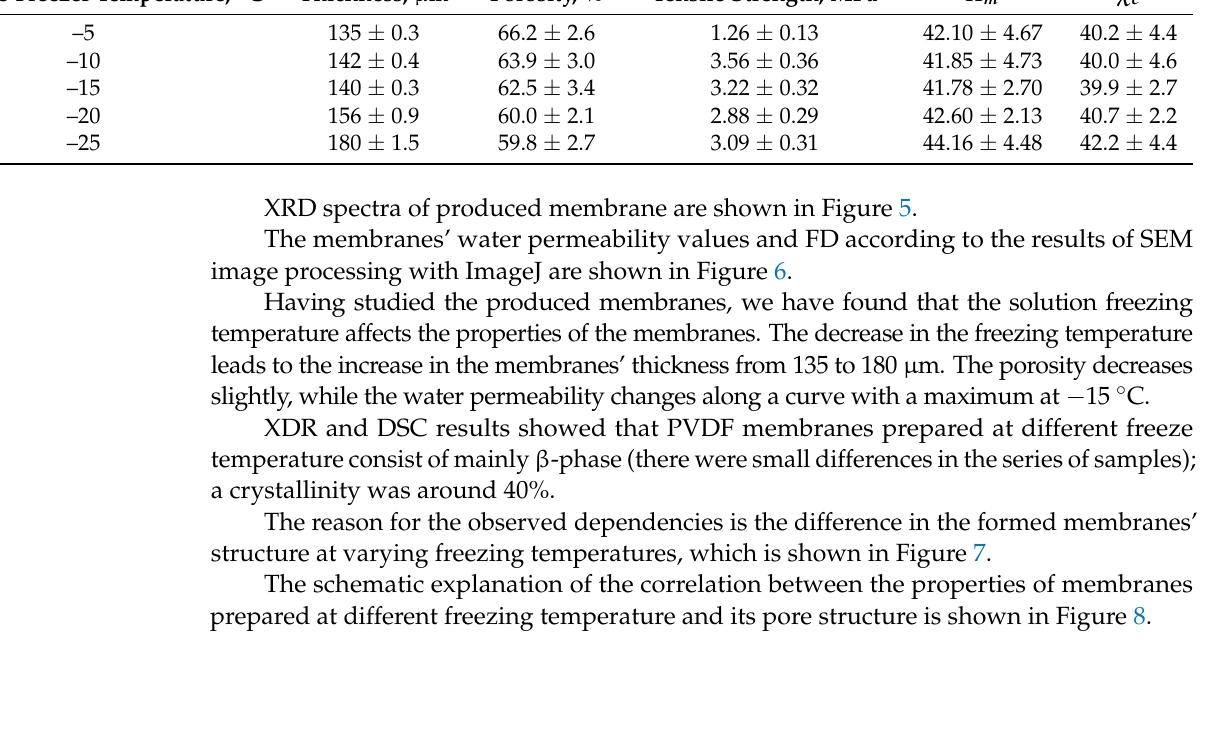
Table 2. Characteristics of the produced membranes depending on the solution freezing temperature. Inside-the-Freezer Temperature, ◦